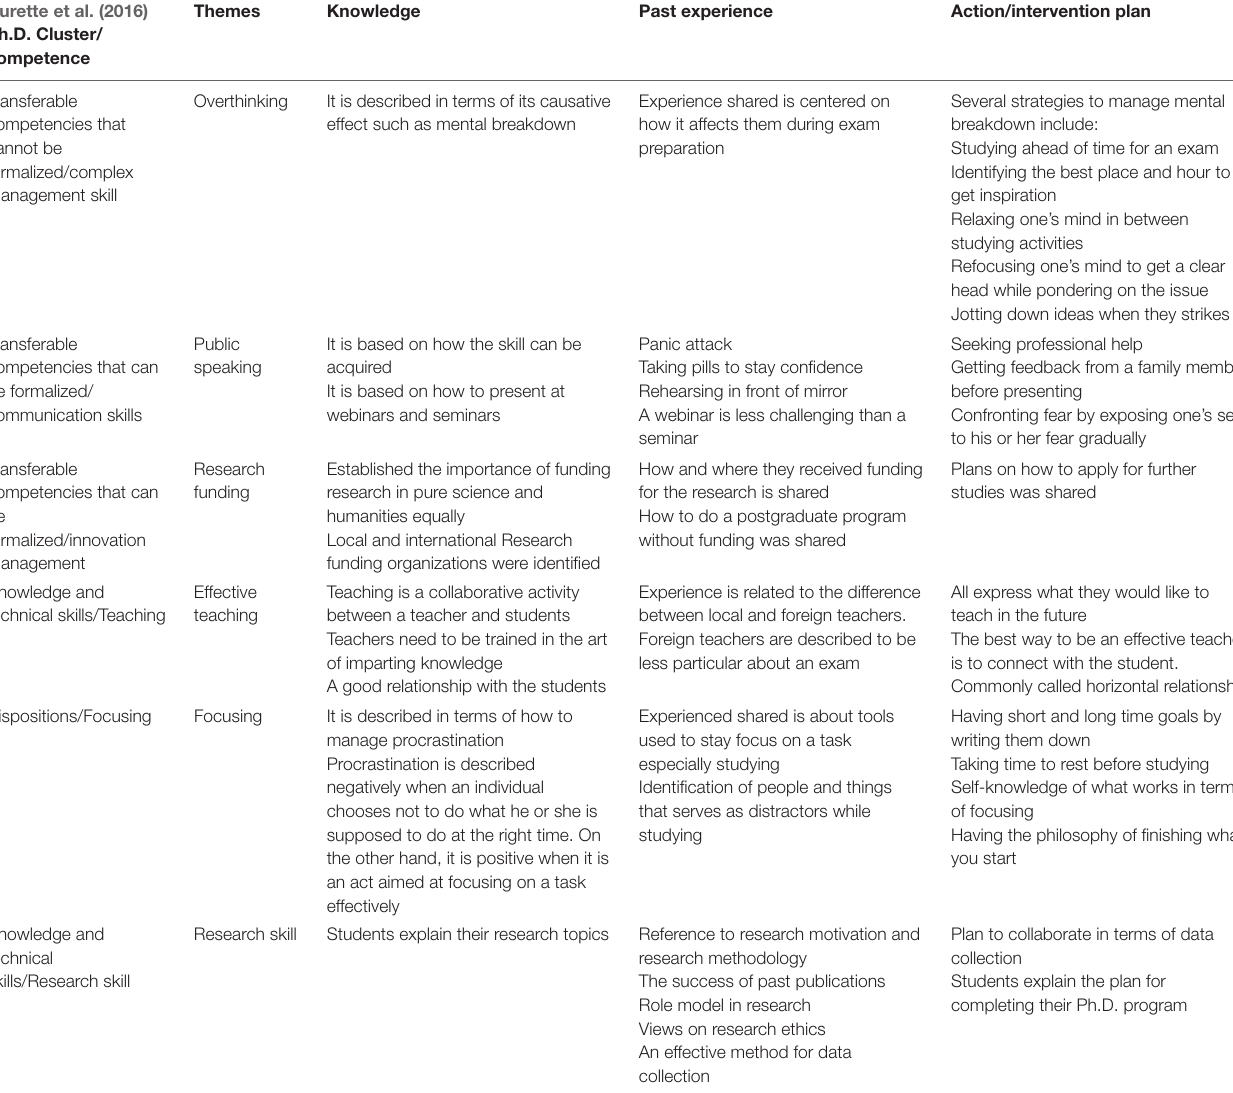
TABLE 1 | Assessment of Ph.D. competencies acquisition using selected academic themes with their corresponding Durette et al. (2016) Ph.D. competence. Durette et al. (2016) Ph.D.